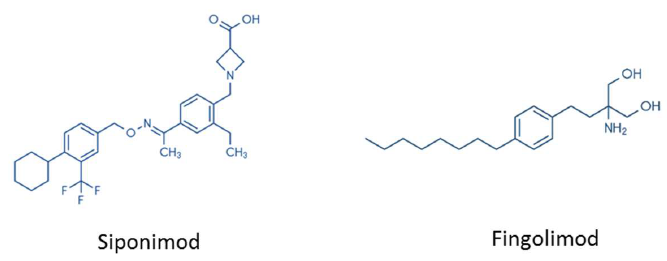
Figure 3. Chemical structures of siponimod and fingolimod.